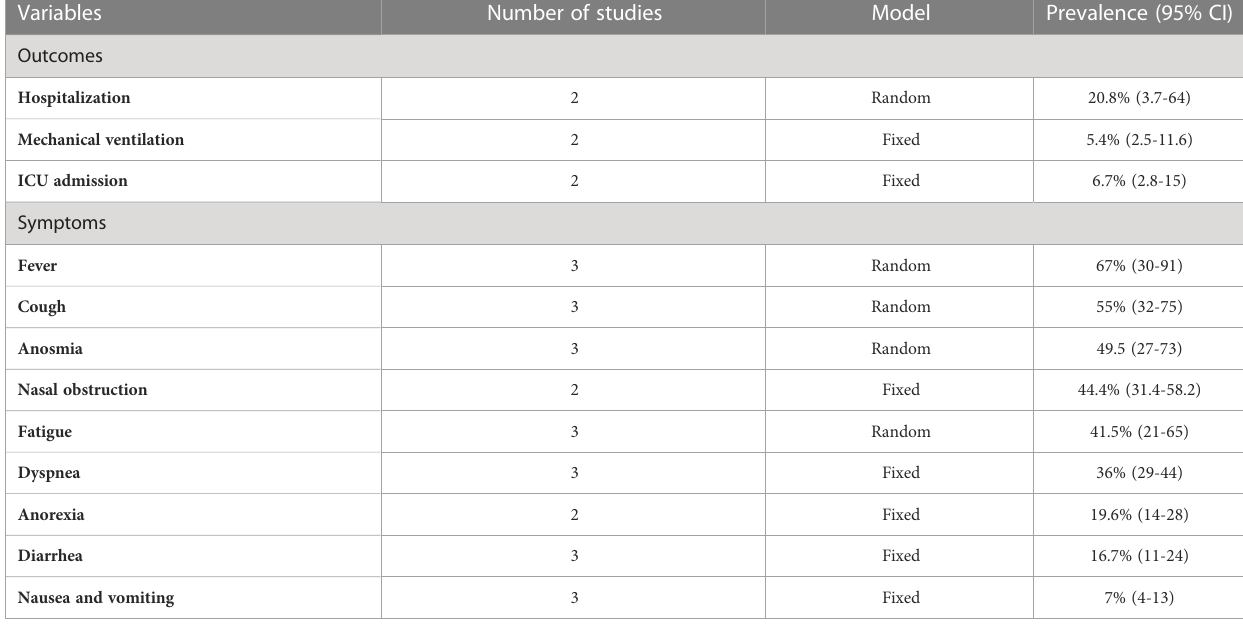
TABLE 2 Prevalence of outcomes and symptoms of COVID-19 patients with chronic rhinosinusitis.